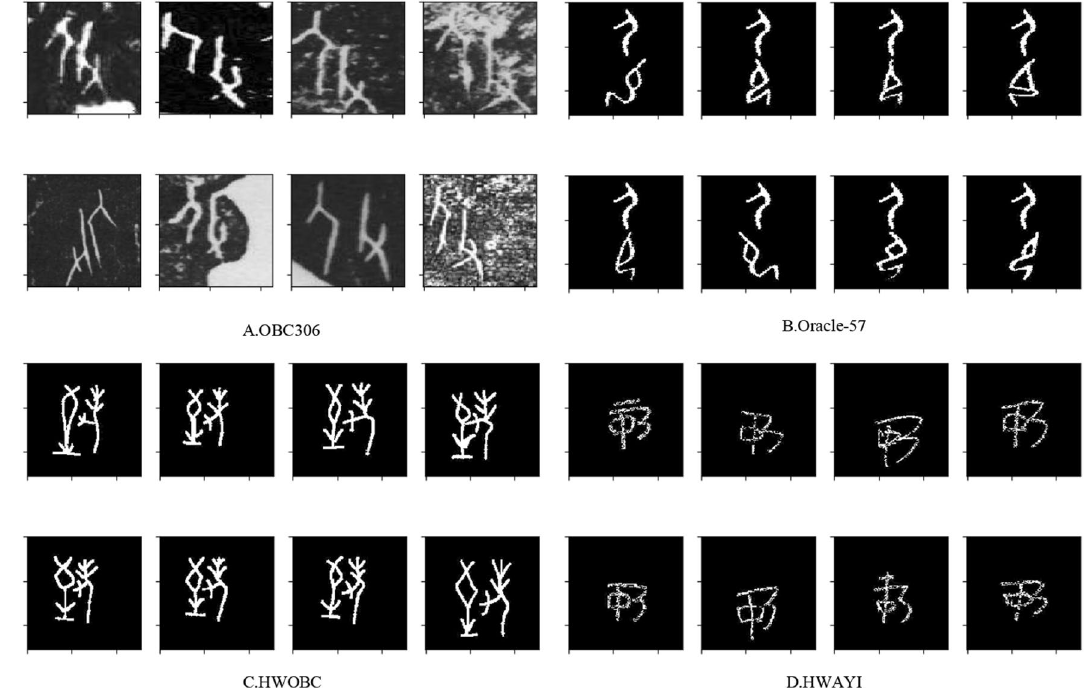
Figure 7. a variety of different images from four different characters in our datasets. Acc